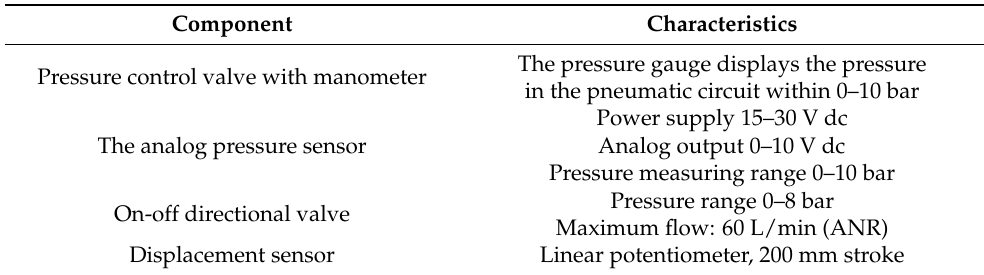
Table 2. Components and characteristics of the experimental setup.